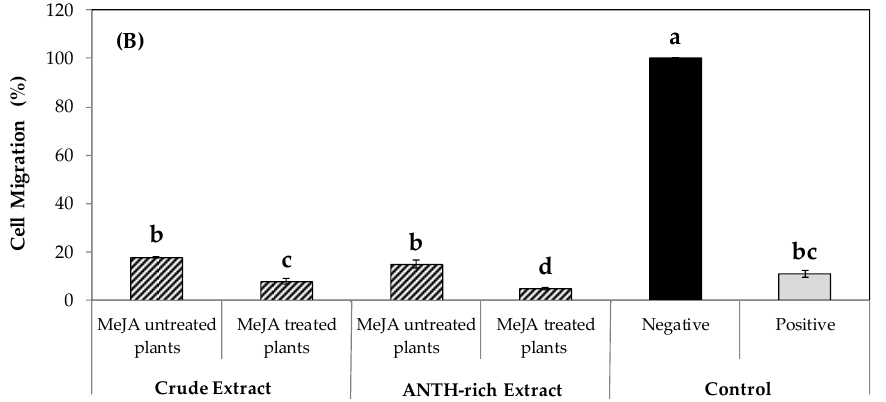
Figure 4. Effect of crude and anthocyanin-rich (ANTH-rich) extracts of leaves from plants untreated and treated with MeJA on cell viability ( A ) and cell migration ( B ) of the AGS gastric cancer cell line. Cell viability was measured after 24 h of extract incubation using AlamarBlue reagent and determining the fluorescence intensity at 530/560 nm. The percentage of viable cells relative to the control cells was calculated. To assess the migratory capacity, cells were exposed to increasing concentrations of leaf extracts during 1 h. The number of cells migrating in the presence of serum-free medium and buffer DPBS represented 100% of cell migration (control), whereas the values of cell migration after the extract exposure were calculated in relation to the control. All extracts were evaluated at a final concentration of 100 µg mL − 1 . Distilled water was used as a negative control, whereas a quercetin aqueous solution (4 µM) was used as a positive control. Lower case letters (a–d) indicate significant differences among the treatments according to the Tukey test ( p ≤ 0.05). Error bars represent the standard error of the data set. ( C ) Representative images of the effect of each treatment on AGS cell migration under a light microscope and 20× objective.